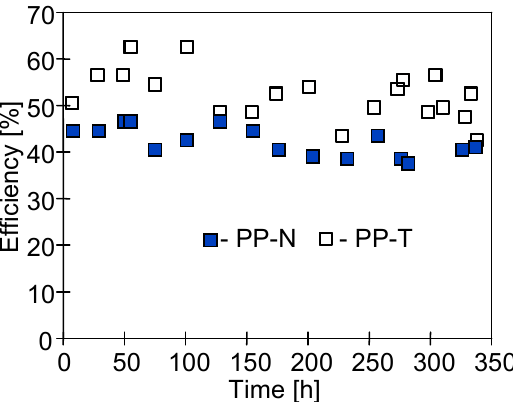
Figure 8. The changes of thermal efficiency of used membrane modules during the MD process.